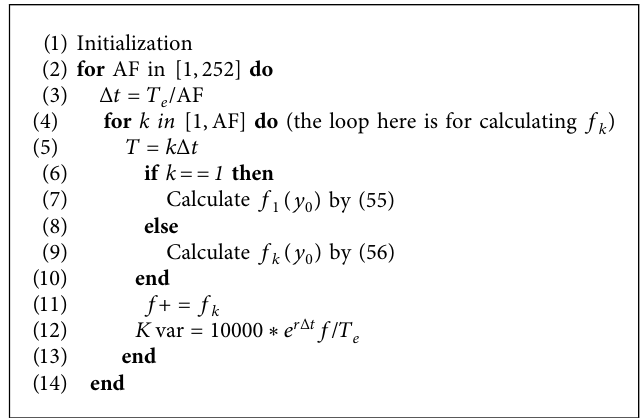
Figure 7: Comparison of K K with different var